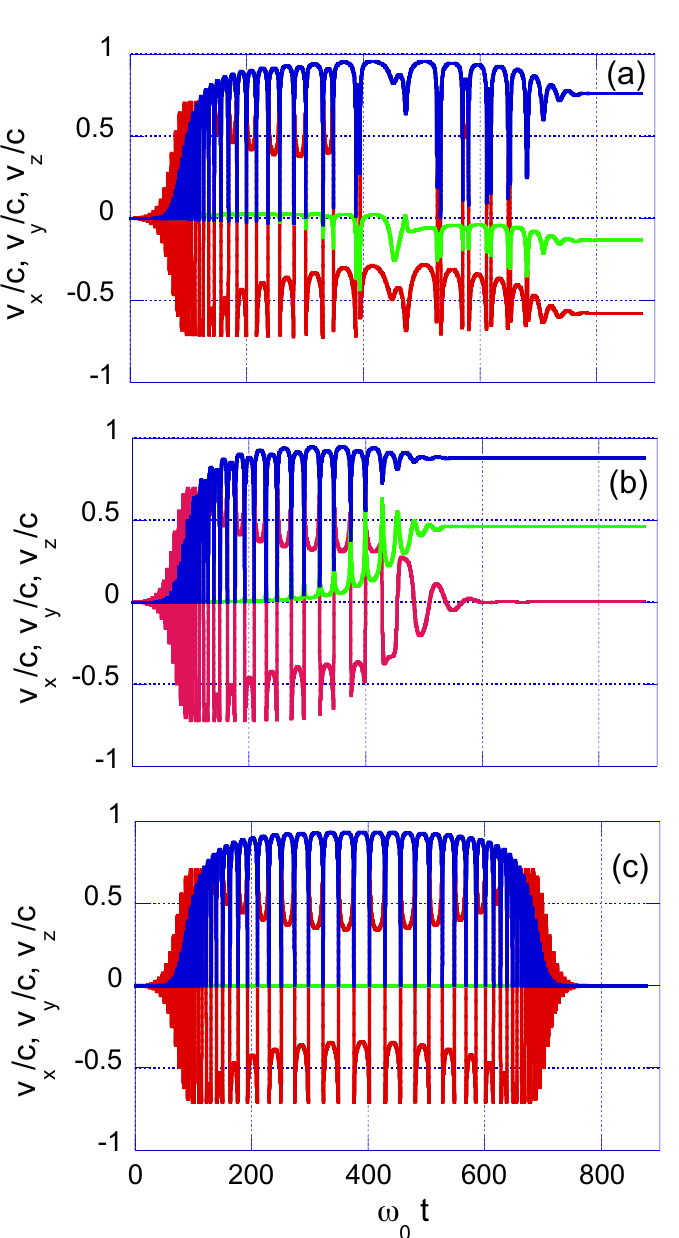
Figure 15. Time evolution of velocity components for paraxial fields (top and medium panels) versus √ analytical solution (bottom panel). Initial conditions on top panel are x 0 = w 0 / 2, y 0 = 0, z 0 = 0 √ and in medium panel y 0 = w 0 / 2, x 0 = 0, z 0 = 0. No quantitative agreement with the analytical solution is found in this case. Color code is red, green and blue for v x / c , v y / c and v z / c respectively. Temporal axis is given as the dimensionless product ω 0 × t